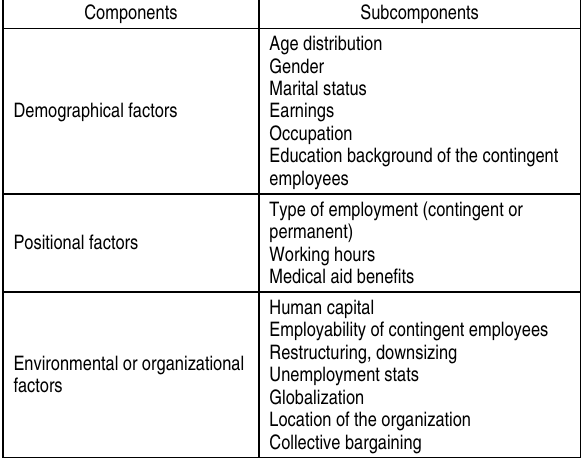
Table 1. Job insecurity